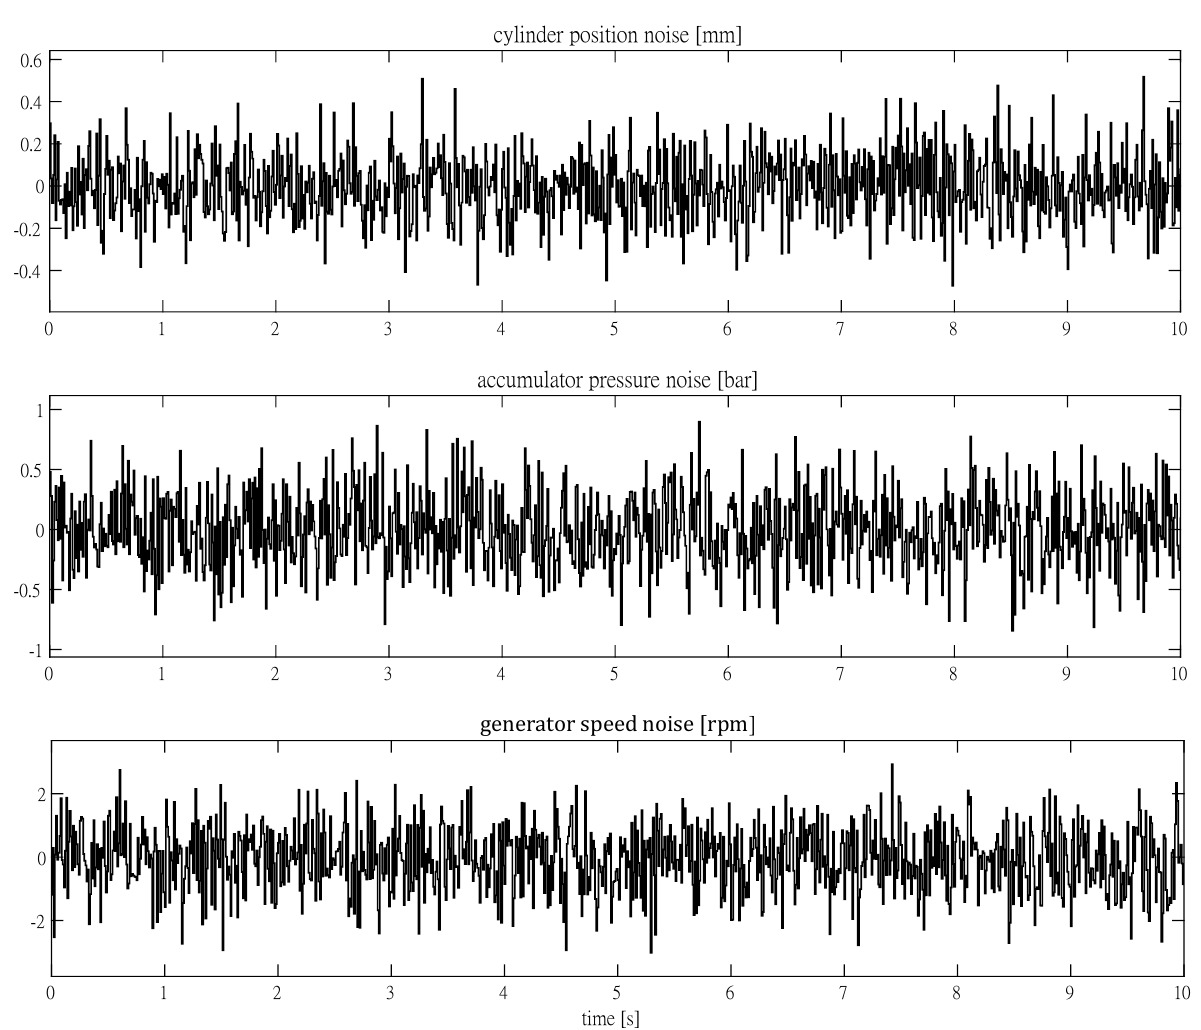
Figure 8. Noise levels added to simulated